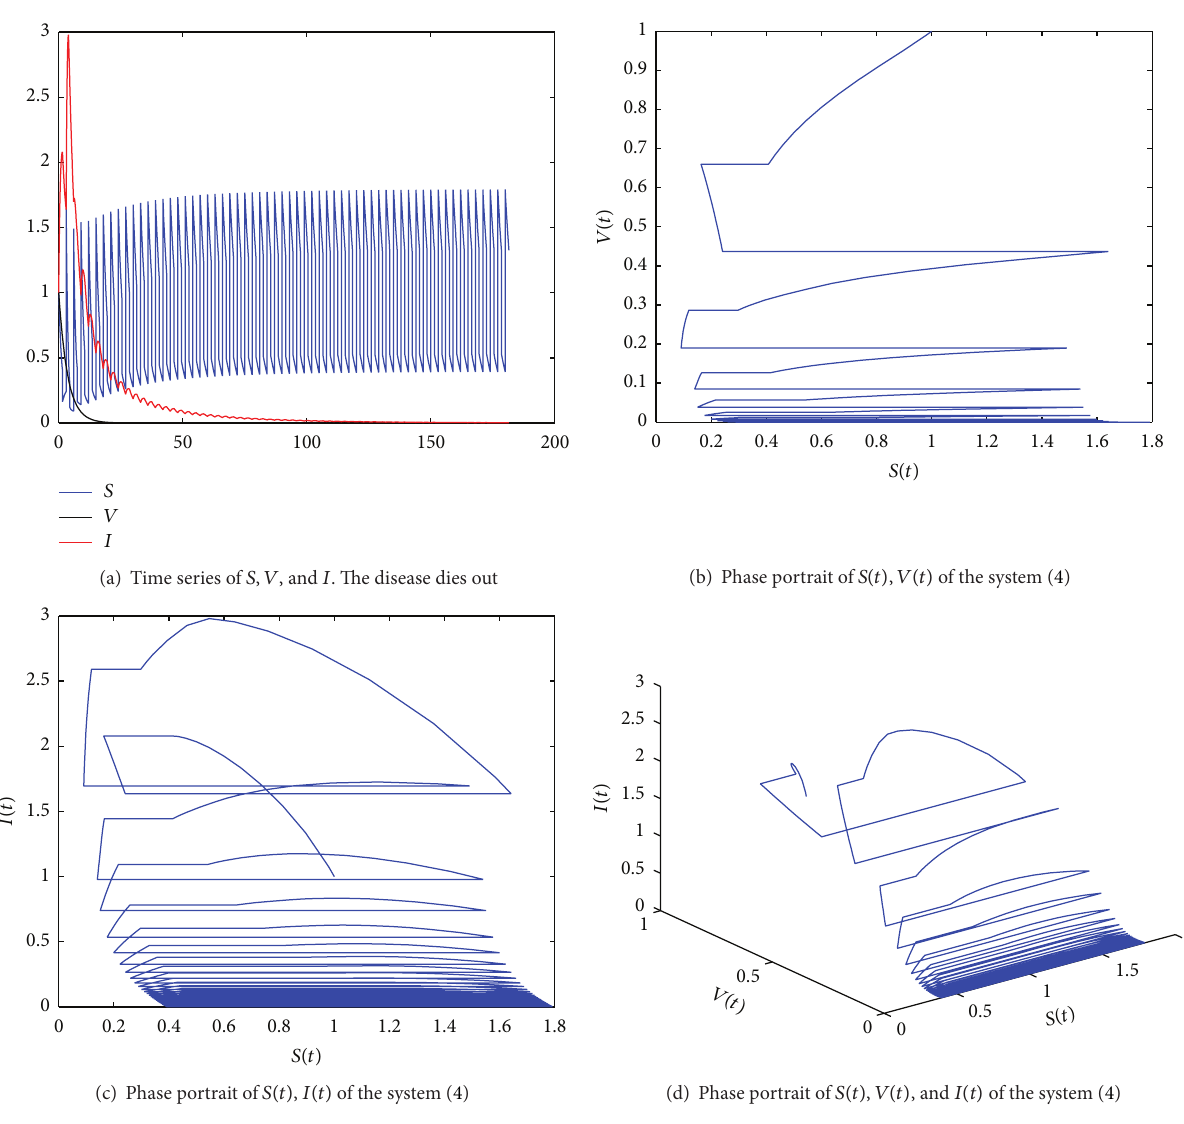
Figure 2: The results of numerical simulation on the threshold values R 1 = 0.0339 < 1 , where 𝑝 = 1.5 , 𝑞 = 1.25 .